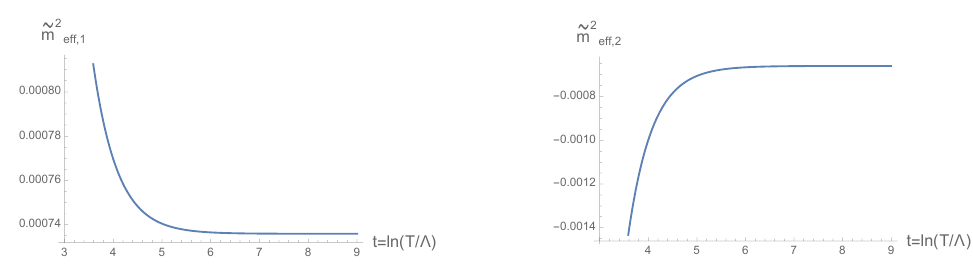
Figure 11. Plots of the rescaled effective masses (squared) against t = ln( T/ Λ) for r = 0 . 1 , θ = π , λ = 0 . 001 , c 1 = 0 , c 2 = 0 . 1 :